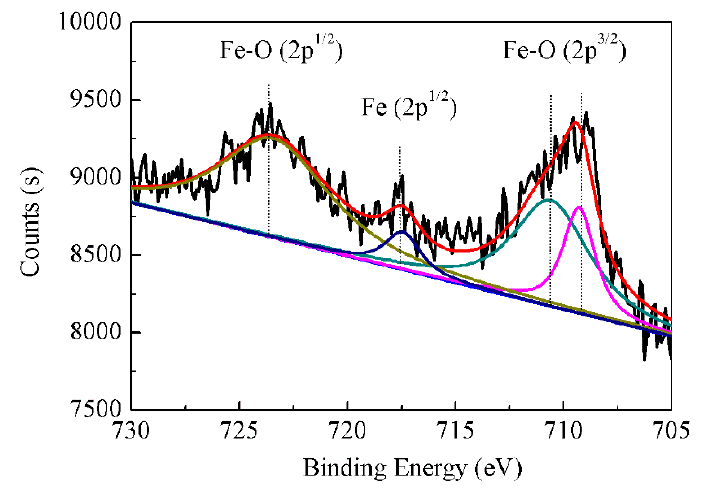
Figure 15. X-ray photoelectron spectra for Fe2p of the fabricated multiphase coating.